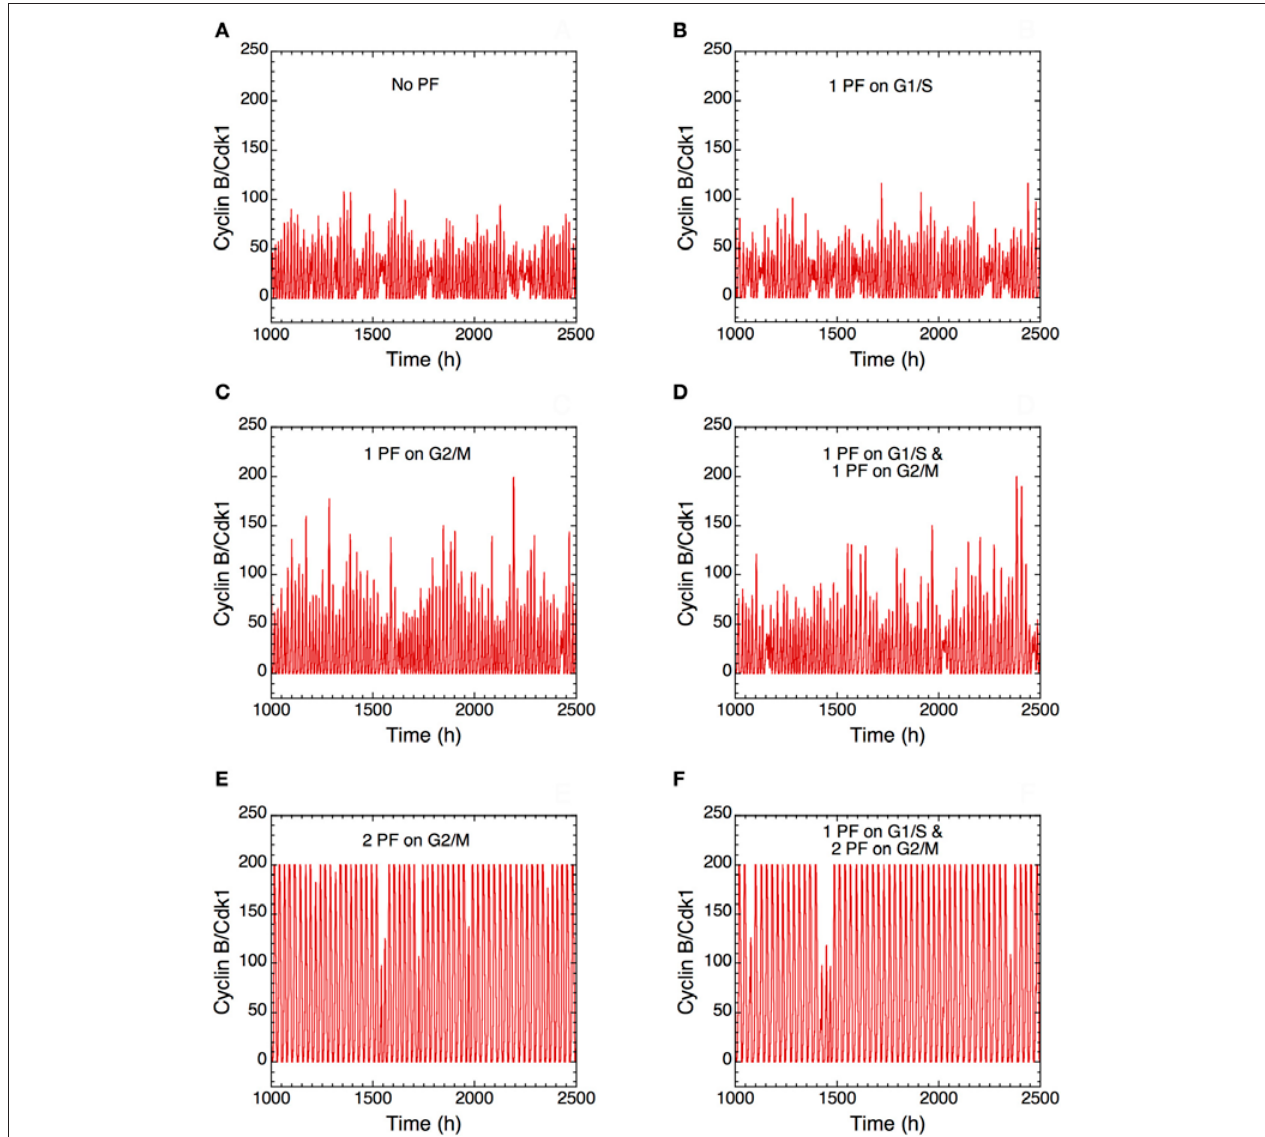
FIGURE 14 | Positive feedback loops increase the robustness of Cdk oscillations with respect to molecular noise. The long-term time evolution of cyclin B/Cdk1 is shown in the extended version of the skeleton model for the mammalian cell cycle (Gérard et al., 2012) (A) in the absence of PF loop ( b 1 = 0, b 2 = 0, K ib = 1000 μ M) or in the presence of (B) one PF on G1/S via Cdc25 ( b 1 = 1, b 2 = 0, K ib = 1000 μ M), (C) one PF on G2/M via Cdc25 ( b 1 = 0, b 2 = 1, K ib = 1000 μ M), (D) one PF on G1/S and one PF on G2/M via Cdc25 ( b 1 = 1, b 2 = 1, K ib = 1000 μ M), (E) two PF on G2/M via Cdc25